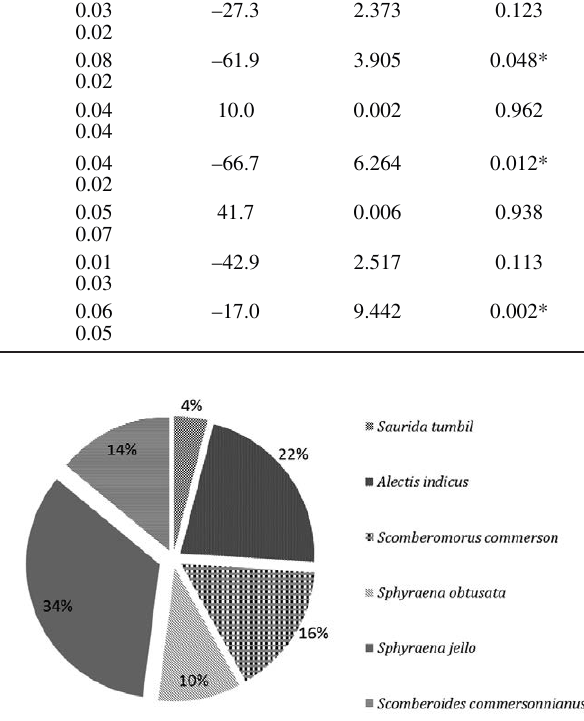
Fig. 4. – Percent dissimilarity for captured species between handline and trolling fishing